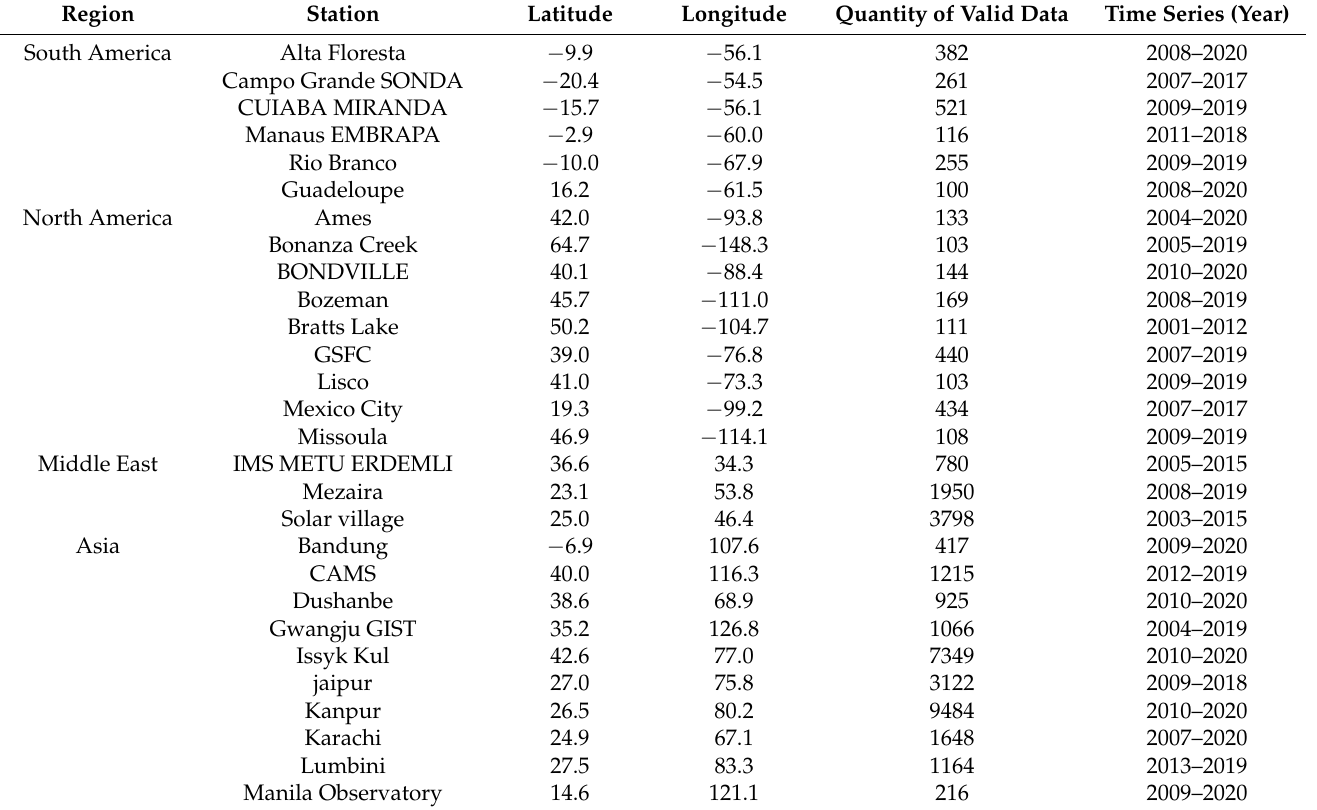
Table 1. The latitude, longitude and quantity of valid data (if the PLDR are available) collected from 52 stations used in this research. The stations are grouped in eight regions.